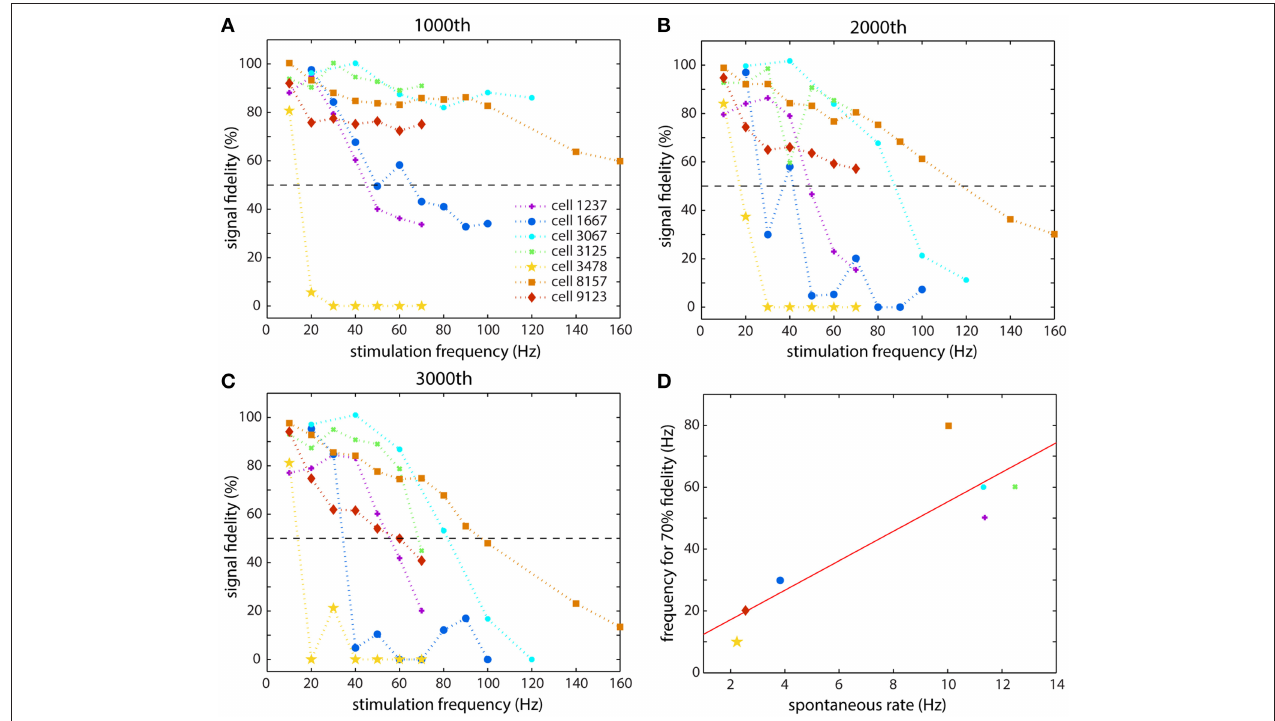
FIGURE 4 | Summary of the responses of seven different cells that were studied. The spike fidelity (normalized spike height minus normalized latency) is shown for each cell at each stimulation frequency at different time points: (A) after 1000 stimulations, (B) after 2000 stimulations, and (C) after 3000 stimulations. (D) The spontaneous firing rate of a cell appeared to be related to the stimulation frequency that it could propagate faithfully. The abscissa is the average spontaneous spiking frequency of the cell and the ordinate is the frequency that the cell could propagate with 70% fidelity, taken from (C) .